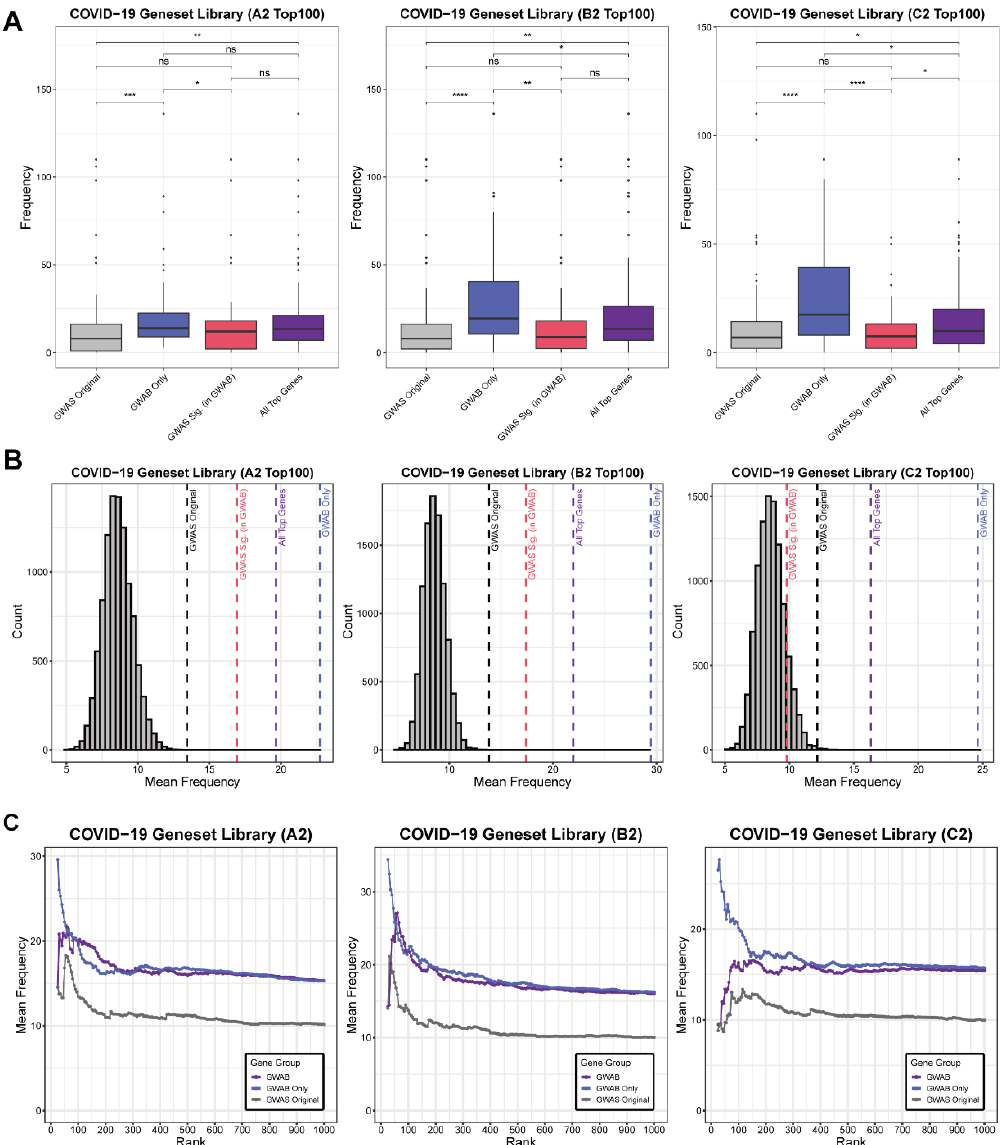
Figure 2. Frequency of appearance in COVID-19 gene set library. Release 6 of COVID-19 HGI GWAS data; A2, B2, and C2 are used. GWAS Originals are top GWAS results based on GWAS statistics p values without boosting. GWAB Onlys are genes in GWAB Top N results (ranked with GWAB scores) that have GWAS statistics p values bigger (not significant) than 5 × 10 − 8 . GWAS Sigs are genes in GWAB Top N results with GWAS statistics p values smaller (significant) than 5 × 10 − 8 . All Top Genes are genes in GWAB Top N results. ( A ) Comparison of frequencies of GWAB top 100 genes for each gene group. The Wilcoxon signed-rank test is used for the p values. Statistical significance: ns ( p > 0.05), * ( p ≤ 0.05), ** ( p ≤ 0.01), *** ( p ≤ 0.001), **** ( p ≤ 0.0001) ( B ) Histogram with mean COVID-19 geneset library frequencies of 100 random genes from all genes, repeated 10,000 times. Each dashed line indicates the mean frequency of each gene group. ( C ) Mean frequencies of top- ranked genes from each gene group ranked from 25 to 1000 (increased by 5).